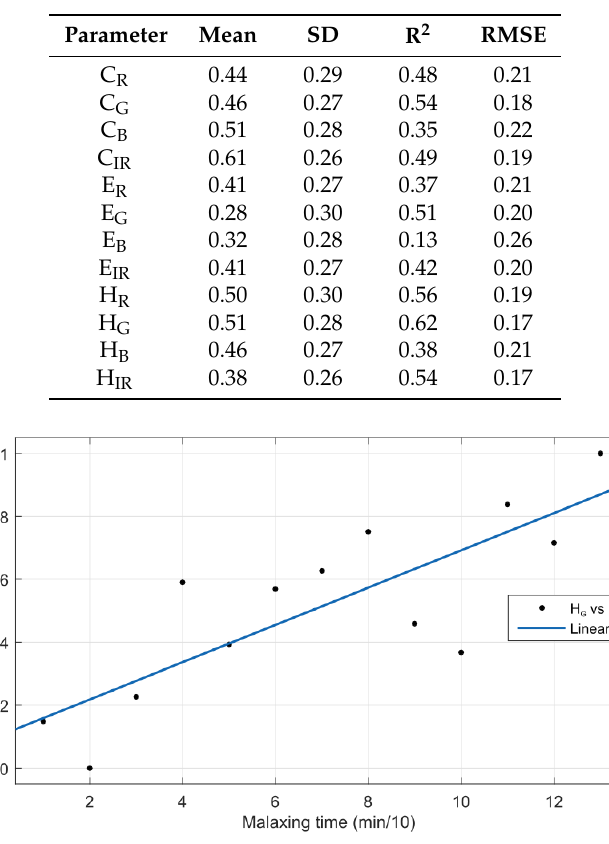
Table 2. Textural parameters.